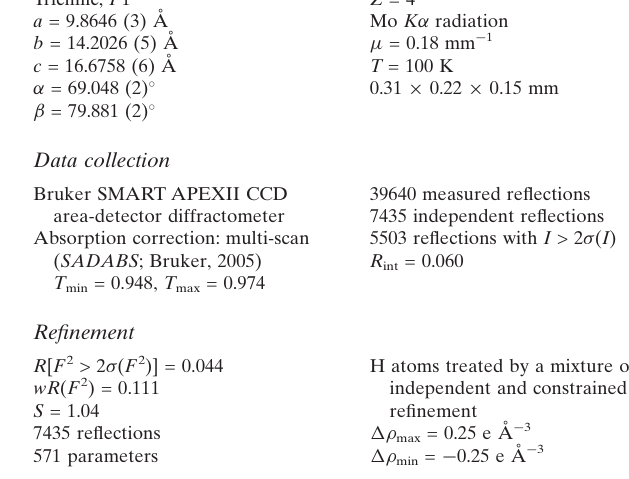
Bruker SMART APEXII CCD area-detector diffractometer Absorption correction: multi-scan ( SADABS ; Bruker, 2005)